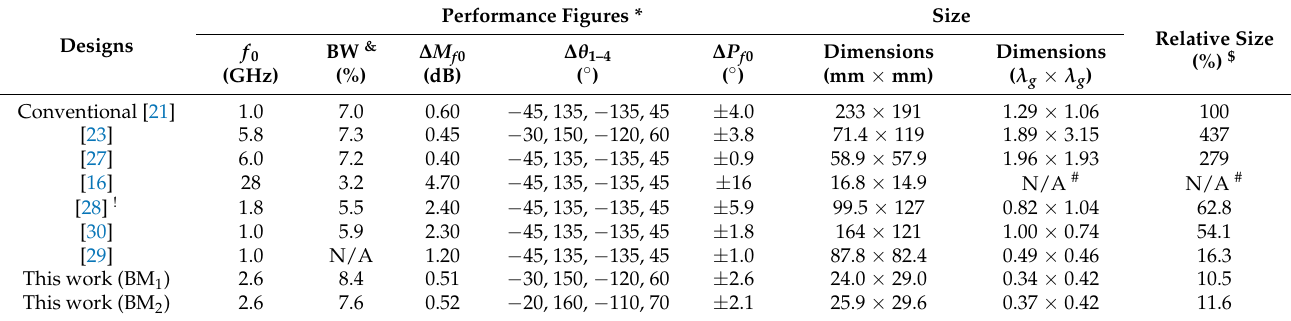
Table 5. Compact BM: comparison with state-of-the-art structures from the